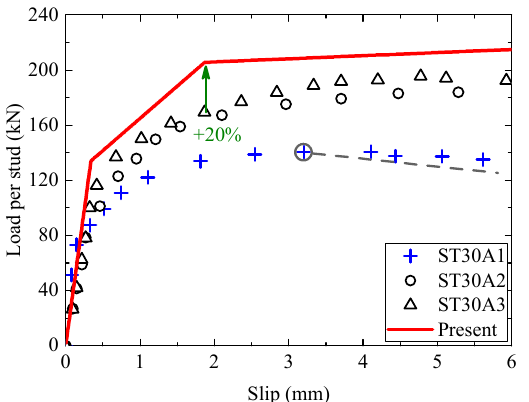
Figure 12. The comparison of load–slip curves between the test and the analytical method for